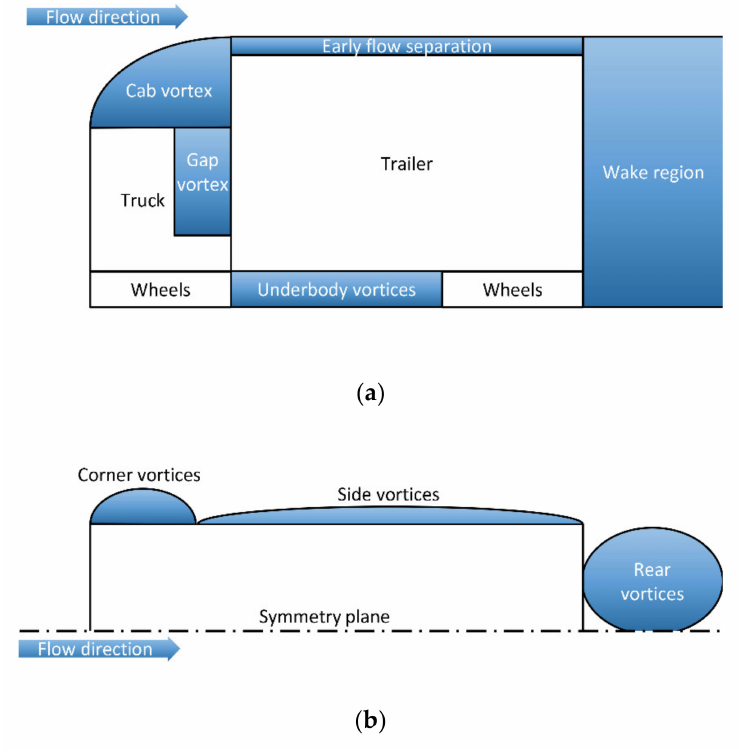
Figure 2. Side ( a ) and top ( b ) view of a heavy truck (based on